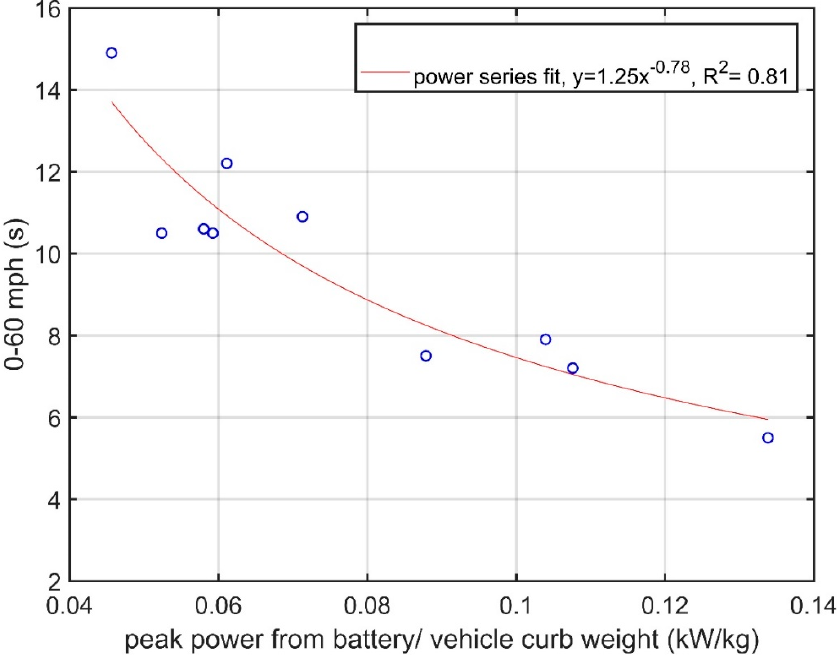
Figure 6. Acceleration for 0–60 mph (s) as a function of peak power from battery normalized by vehicle curb weight.